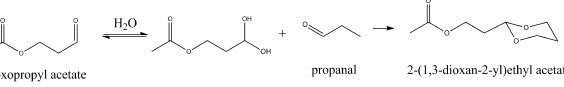
Scheme 2. Upon hydration, aldehyde functionality of 3-oxypropyl acetate could react with propanal, both predicted products of CHA ozonolysis (Scheme 1b), to produce 2-(1,3-dioxan-2-yl) ethyl acetate (VP 5 × 10 − 7